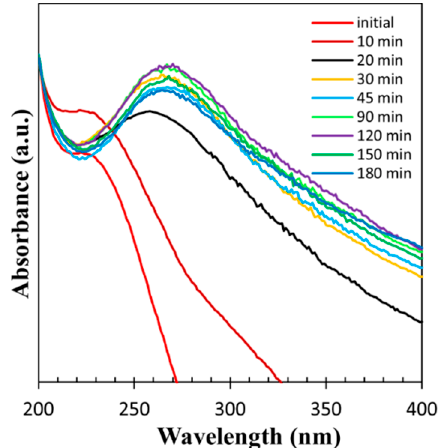
Figure 2. Time-dependent UV-vis spectra of the reaction mixture of the reduction of GO to rGO using lemon juice (conditions: pH = 12.3 and 80 °C).